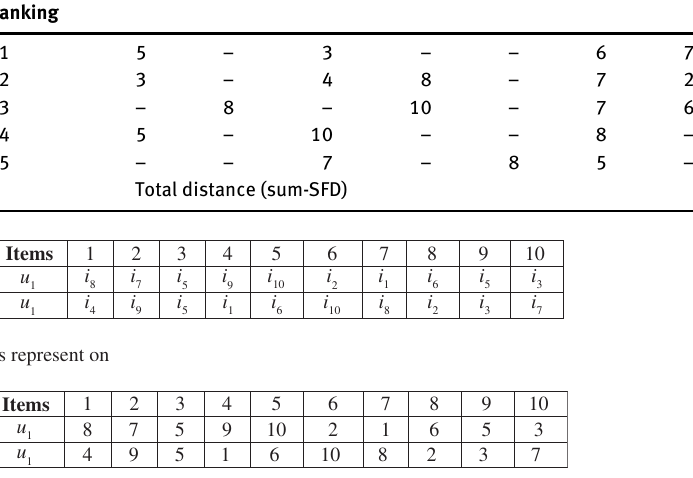
Figure 3: Representation of